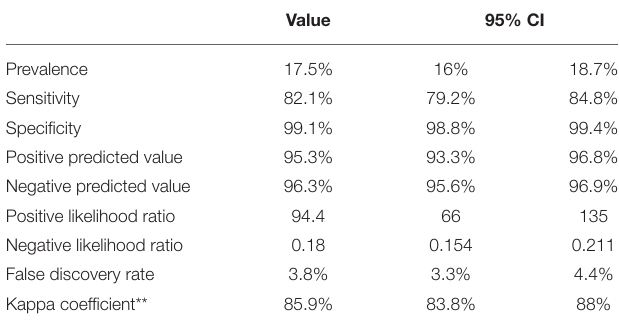
TABLE 3 | Assessment of the diagnostic accuracy of the antigen test.